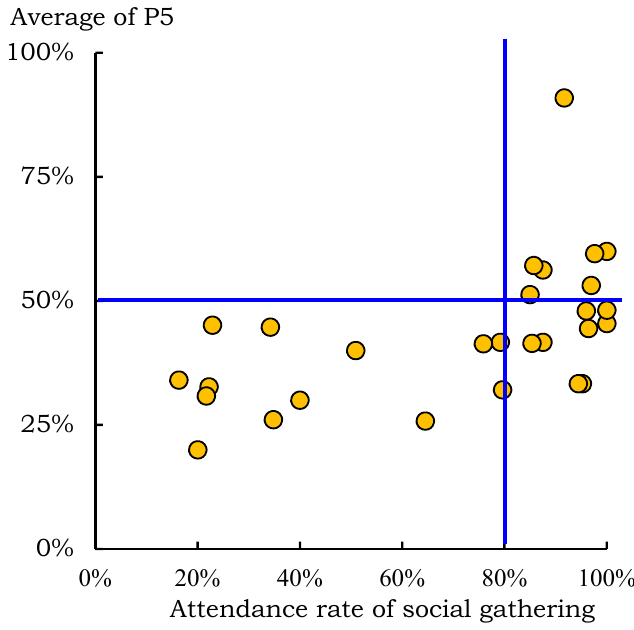
Figure 5. Branch averages of dummy variable P5 and attendance rates of social gatherings of Company X Source: Takahashi (2011) Figure